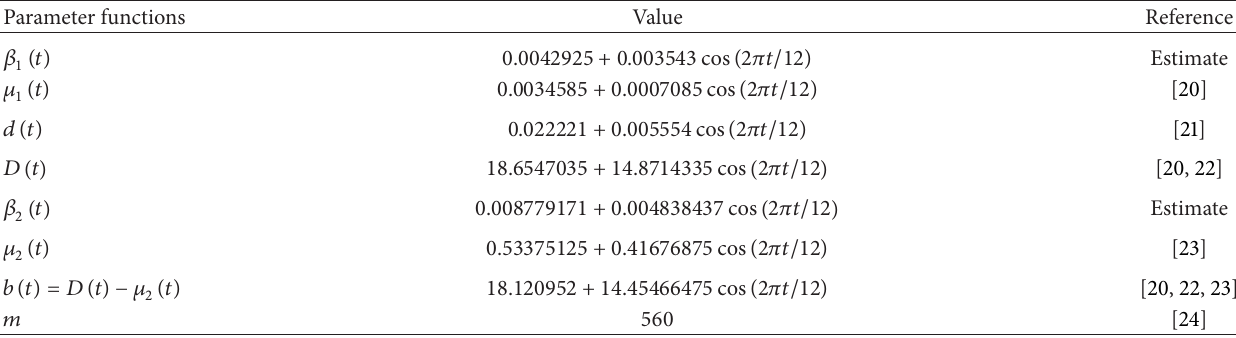
Table 2: Parameter functions for model (1) according to the values of Table